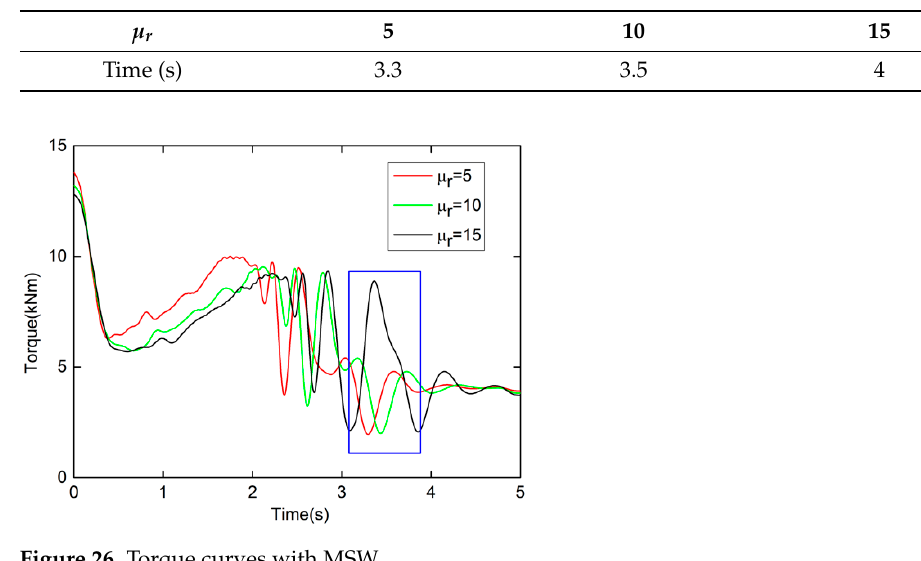
Figure 26. Torque curves with MSW.